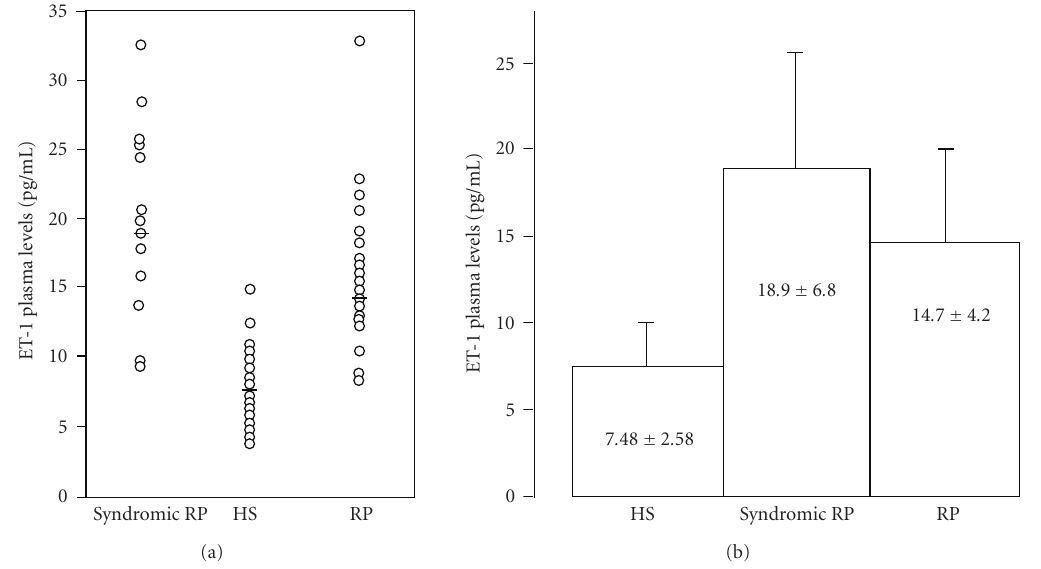
Figure 2: (a) Scatter plot of ET-1 plasma values in patients with retinitis pigmentosa (RP), syndromic retinitis pigmentosa (syndromic RP), and healthy subjects (HS). (b) Mean (M ± SD) plasma ET-1 levels in patients with RP, syndromic RP, and HS. Figure adapted from Vingolo et al. [43].